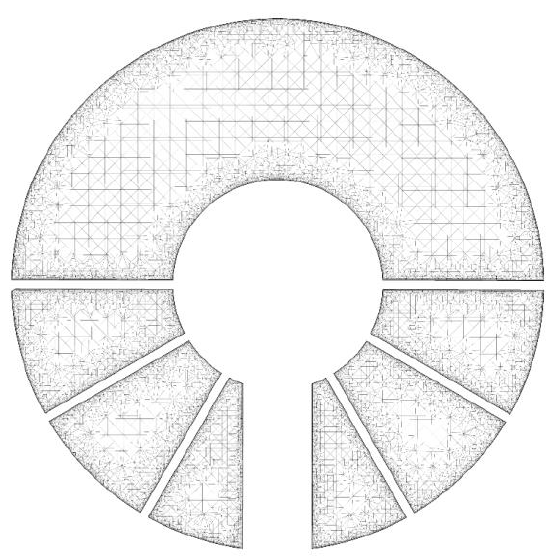
Fig. 8. Detail of the hex-core mesh in the cross-section through the outlet